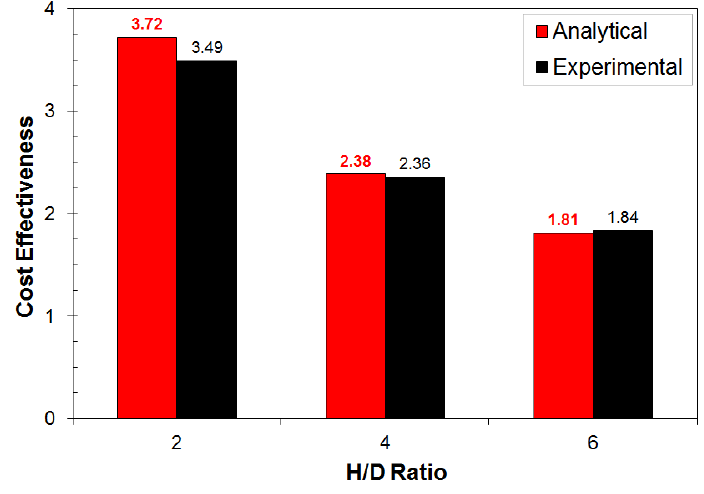
Figure 7. Cost effectiveness parameter from the analytical and experimental